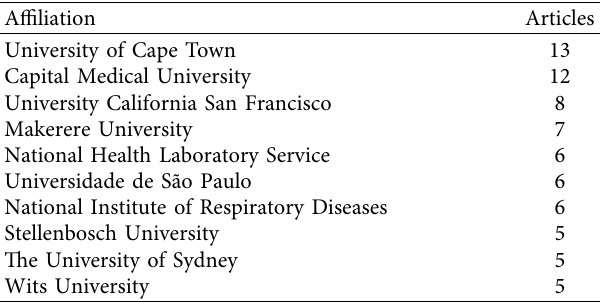
Figure 6: Countries’ production over time. Table 3: Top 10 affiliations that participated in the GeneXpert in